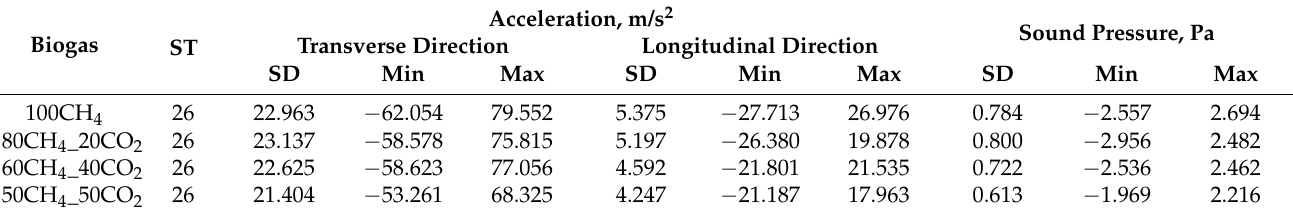
Table 7. Biogas properties and ST cases.